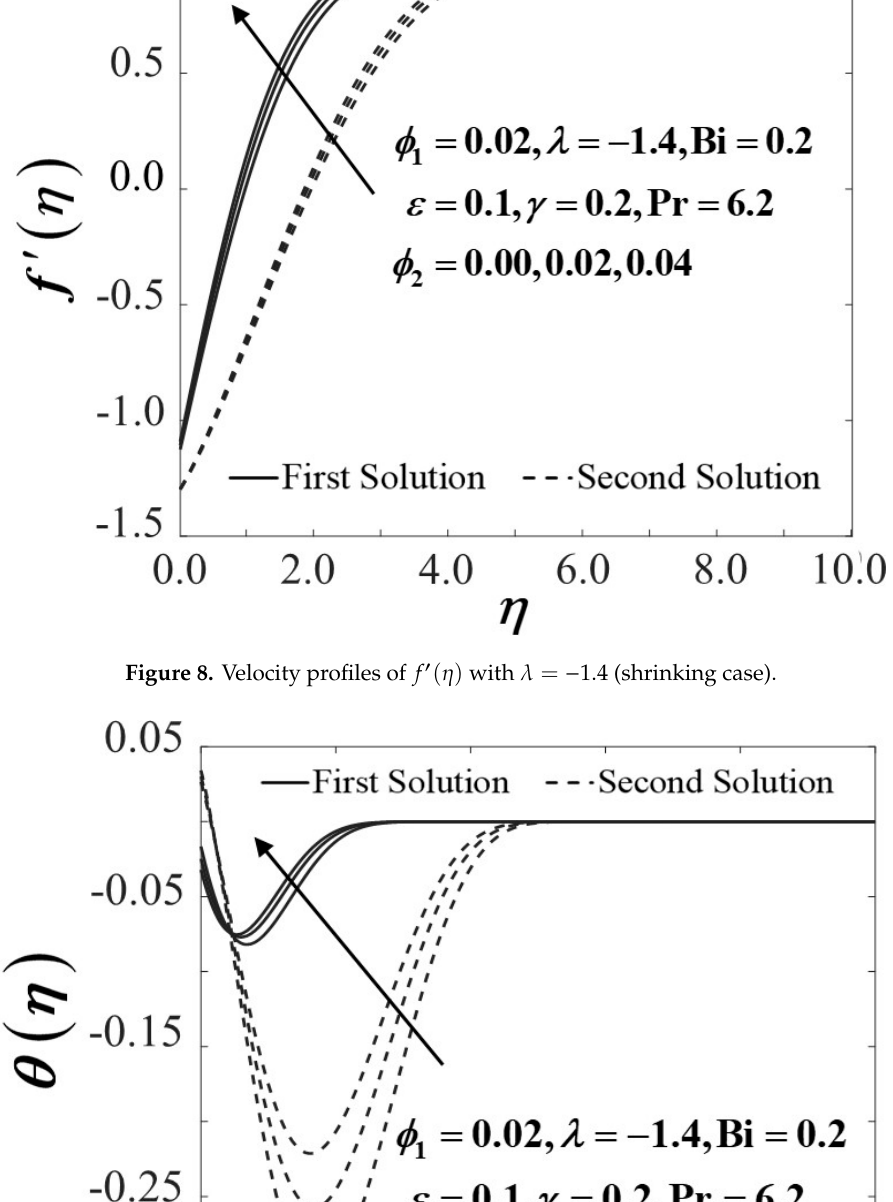
Figure 7. Variants of